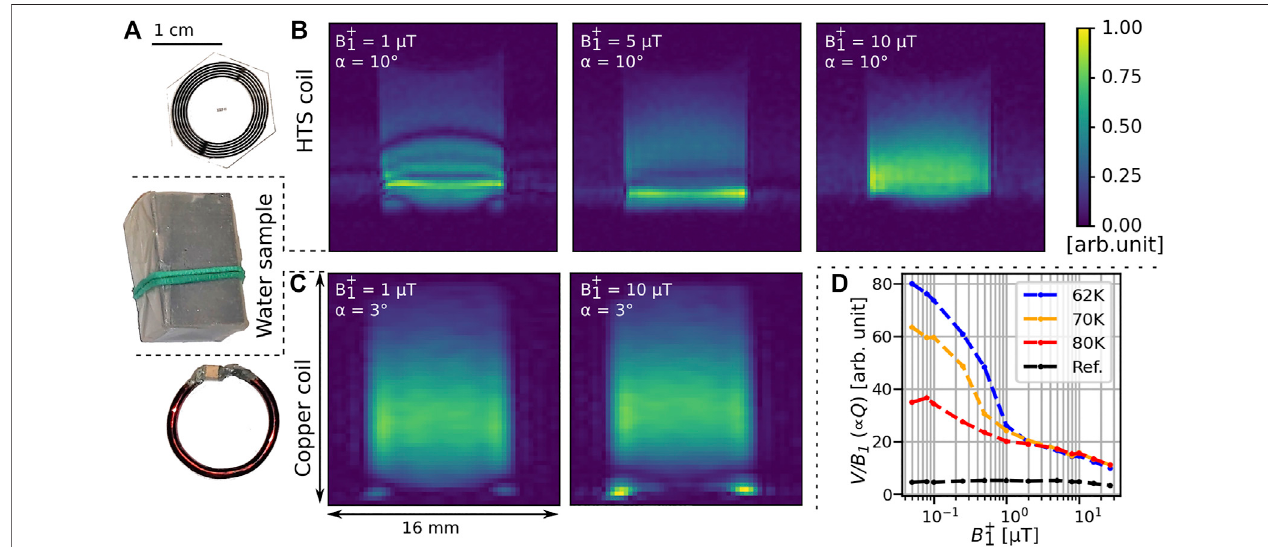
FIGURE 5| (Setup 2) – (A) Pictures ofthe HTS coil, water sample and copper coil. MR acquisitions obtained with (A) the HTS coil at 60 K and (B) the copper coil at room temperature for different B 1 varying from 1to10 μ Tat constant spin fl ip angle α . (C) V / B + 1 ratios ( ∝ Q ) asafunction ofthe RF magnetic fi eld B + 1 transmitted by the volume coil.